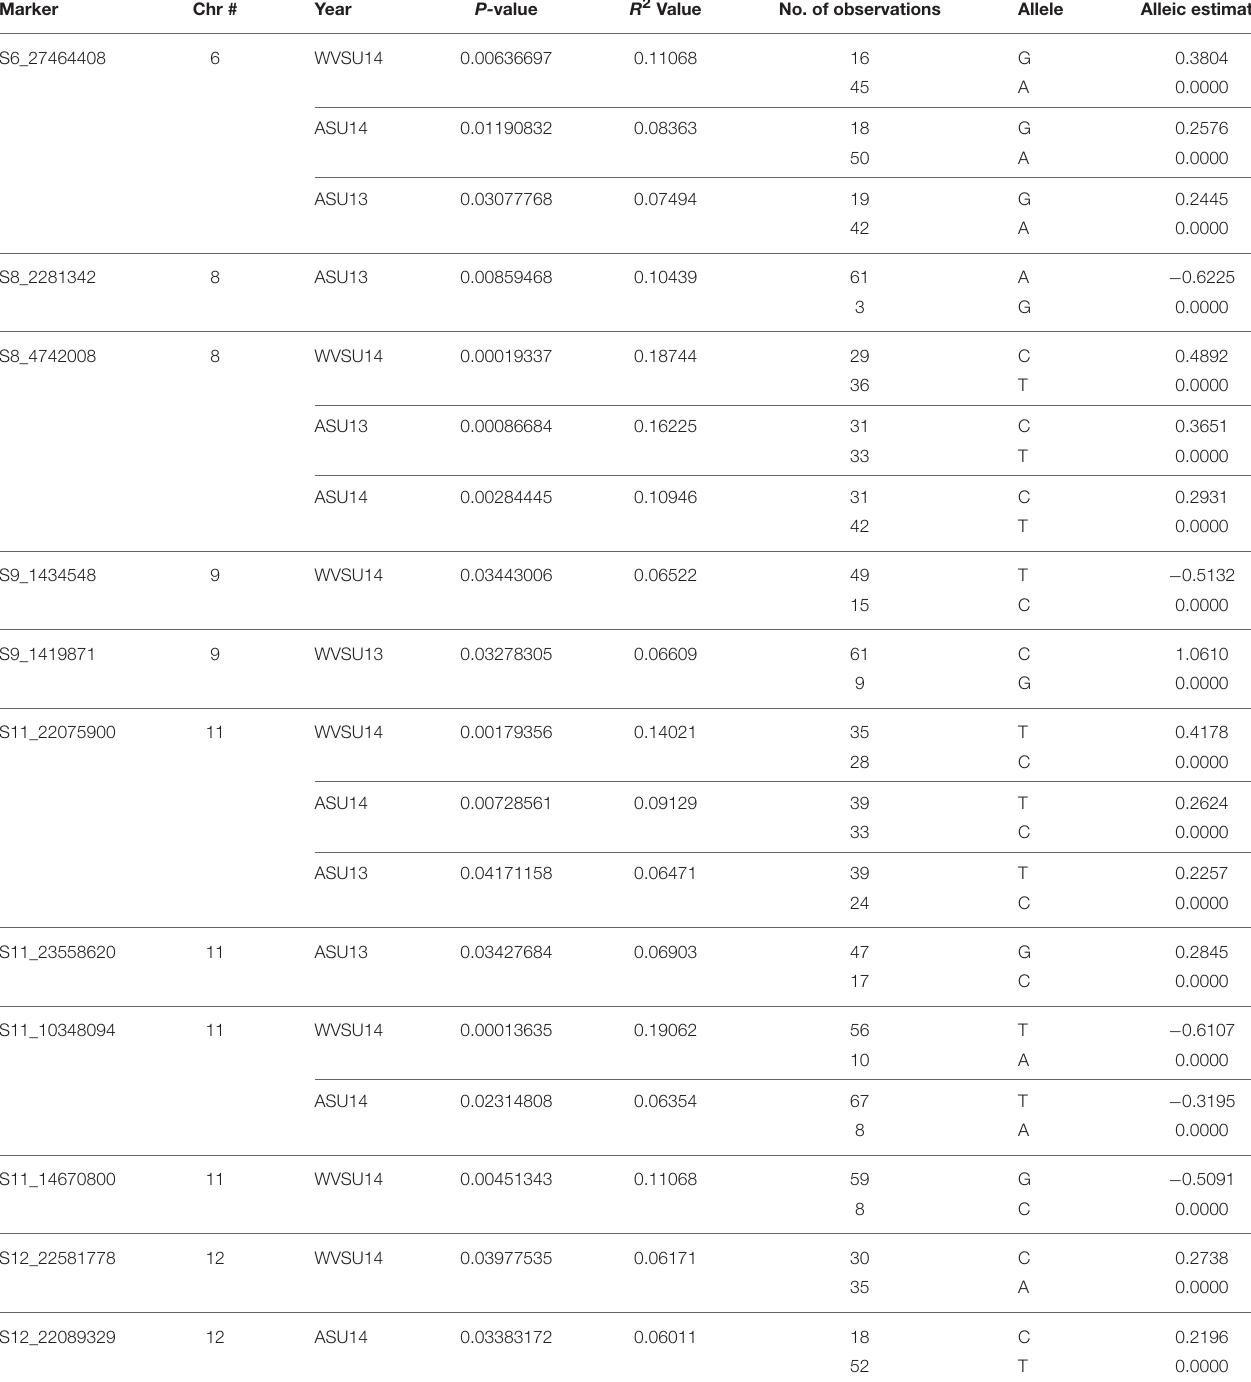
TABLE 2 | Common QTL for fruit firmness identified using GWAS across various years and locations.